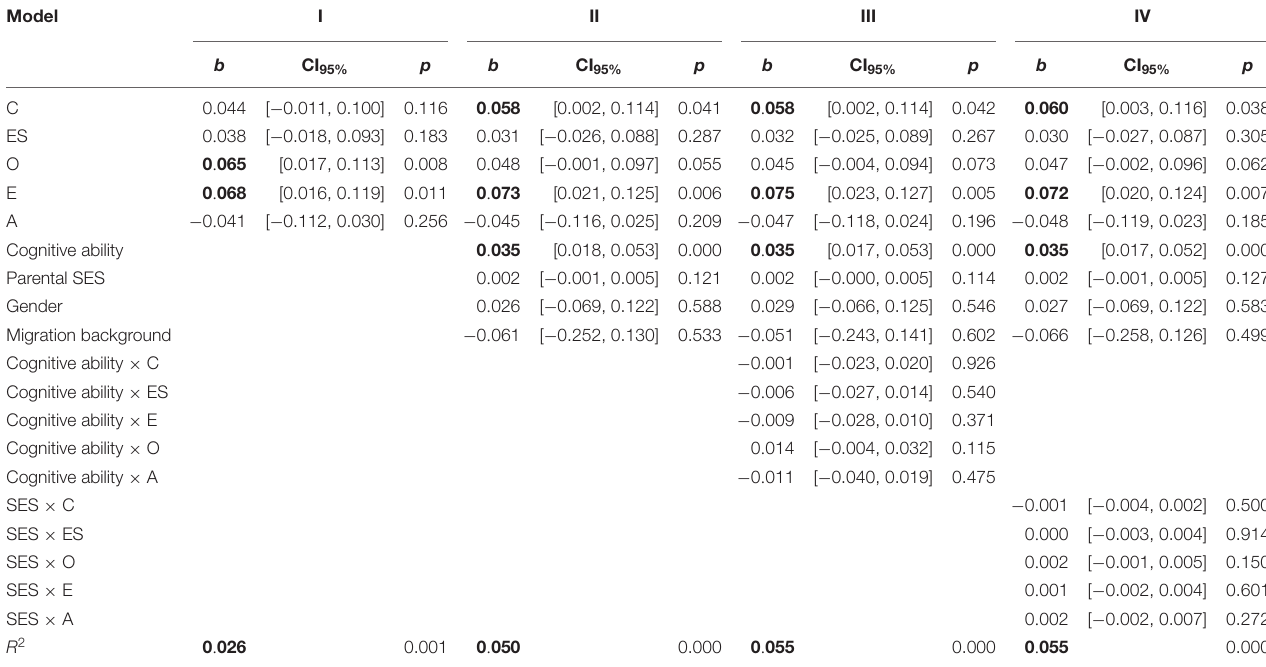
TABLE 8 | Unstandardized regression coefficients for final VET grade regressed on the Big Five and the covariates.